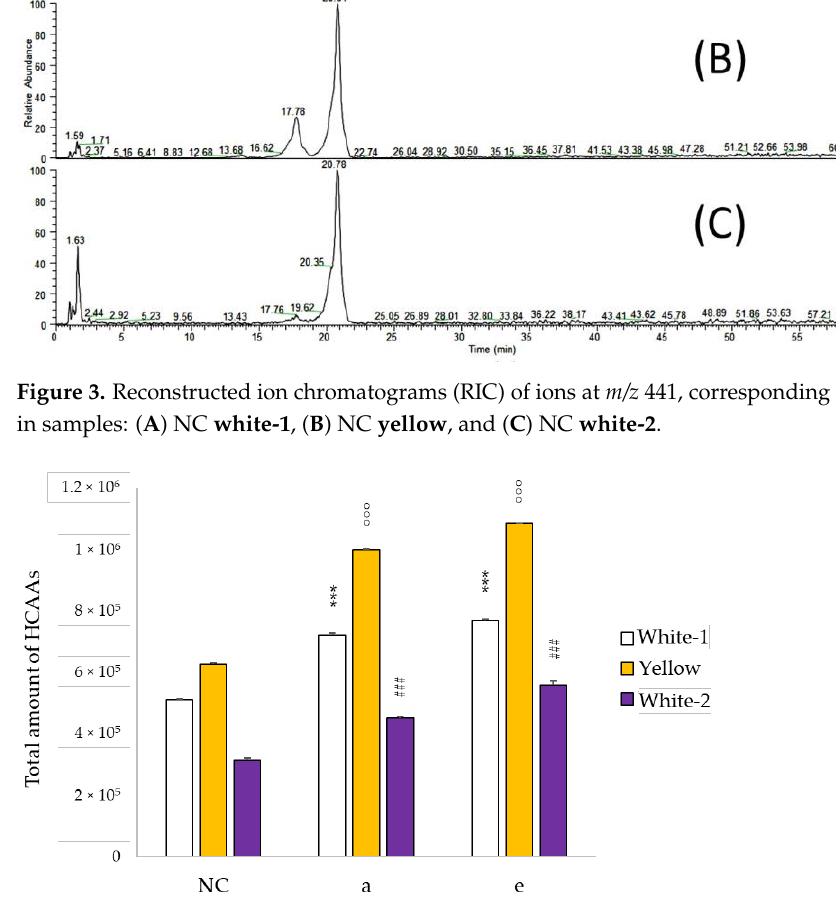
Figure 3. Reconstructed ion chromatograms (RIC) of ions at m/z 441, corresponding to [M + H] + DFP in samples: ( A ) NC white-1 , ( B ) NC yellow, and ( C ) NC white-2 .